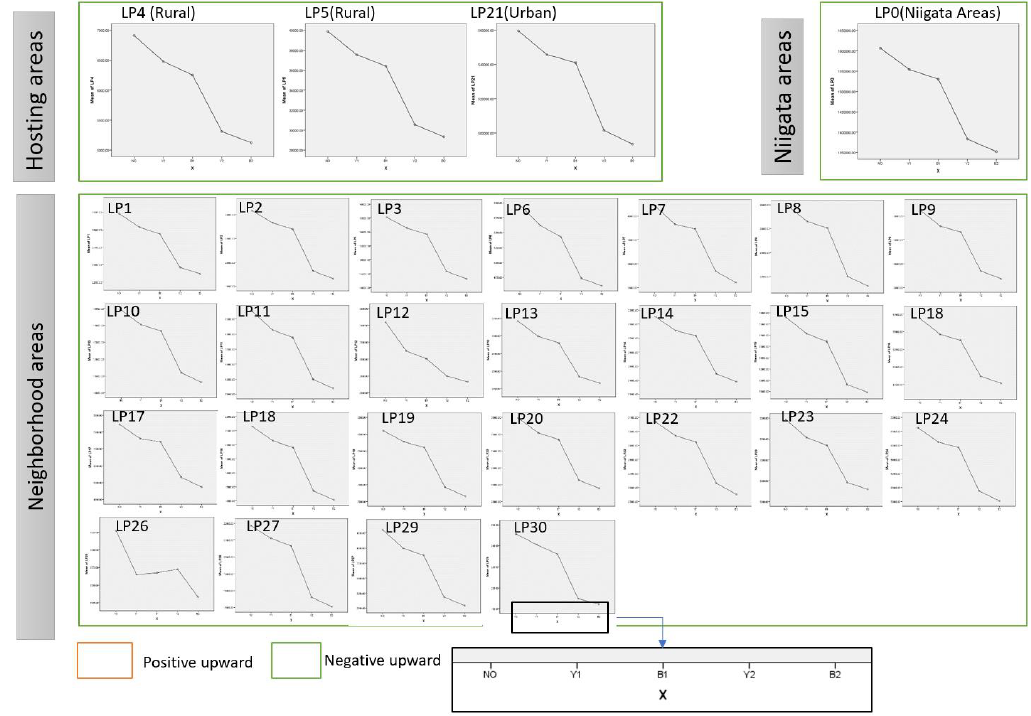
Figure 11. Mean plot (LP, LPGR): other areas in Niigata.